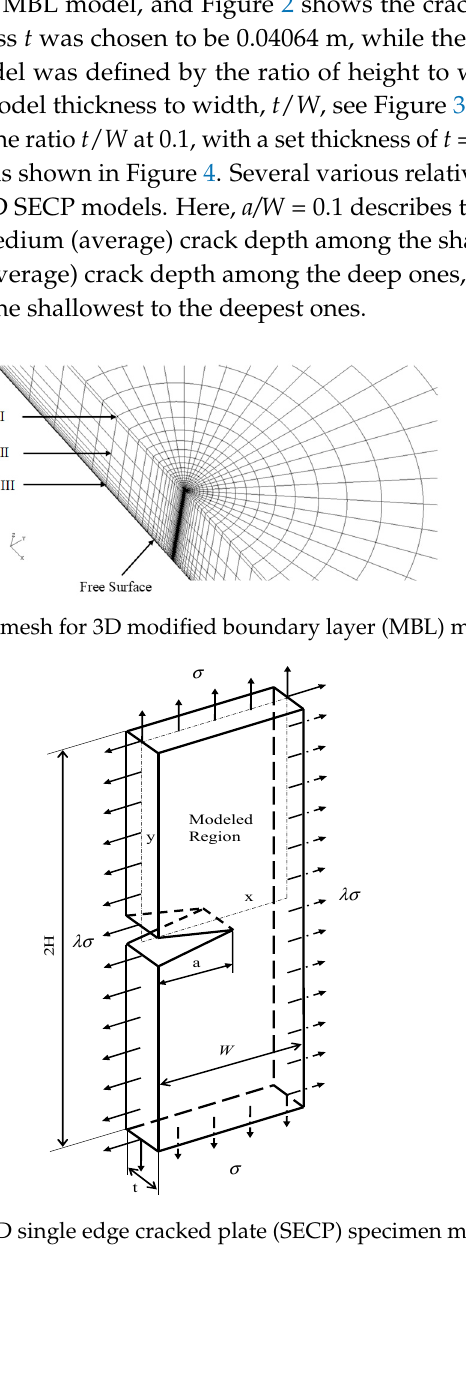
Figure 4. Finite element mesh for 3D SECP specimen (crack front). For current 3D MBL simulation, the value of far-field J -integral was fixed at 2.55 × 10 4 J / m 2 . It was related with K by Equation (9) to simulate the SSY (low load) condition. Finite element analyses were carried out for various T -stress values, T / σ 0 = − 1.0, − 0.8, − 0.6, − 0.4, − 0.2, 0.0, 0.2, 0.4, 0.6, 0.8, 1.0 for several hardening exponent values, n =3, 4, 5, 7, 10, respectively. For 3D SECP structures, biaxial loading was applied to the four edges of 3D models, with a biaxial loading ratio λ = 1.0. During the finite element analysis (FEA) process, the plastic zone size was kept smaller than 10% of the in-plane dimensions ( R for MBL, W for SECP). Maximum several plastic zone sizes were approximately 8.6%. It ensured that all the cases of FEA did not exceed SSY range.